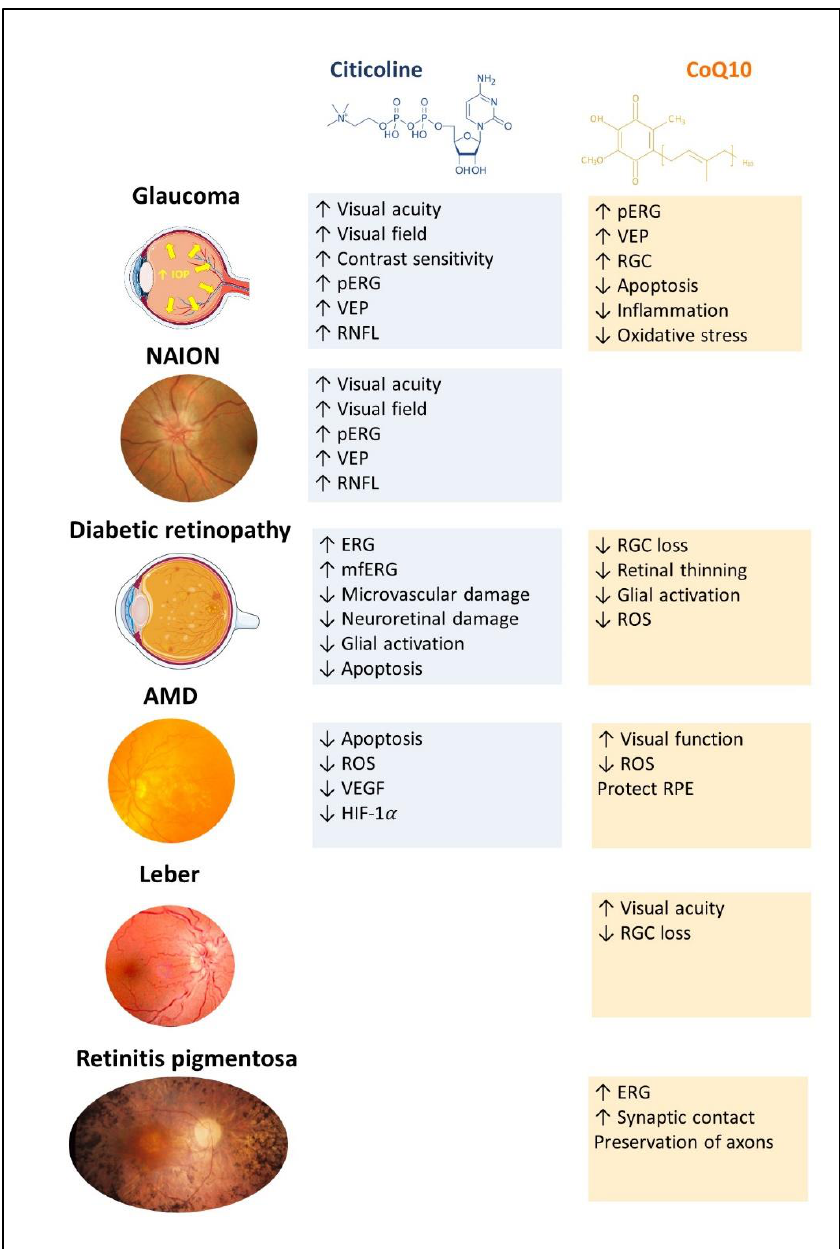
Figure 1. Schematic summary of the main ocular benefits of citicoline and CoQ10 in different ocular pathologies (created in part with smart.servier.com). ERG: electroretinogram; mfERG: multifocal electroretinogram; pERG: pattern electroretinogram; RGC: retinal ganglion cell; ROS: reactive oxygen spices; RNFL: retinal nerve fiber layer; VEGF: vascular endothelial growth factor ; VEP: visual evoked potential.